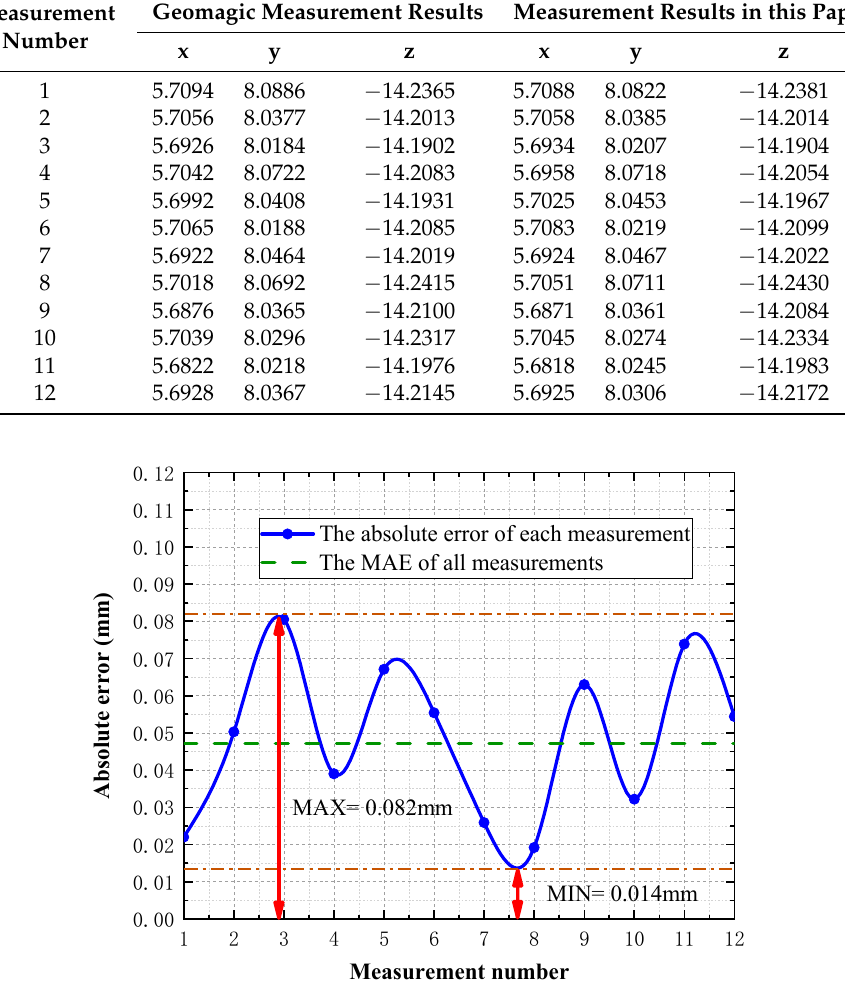
Figure 13. RMSE of the reconstructed sphere 3D model.